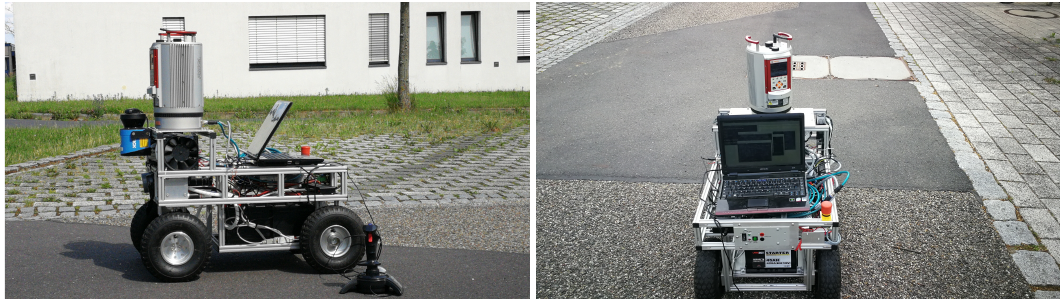
Figure 1. Images of the mobile robot mapping